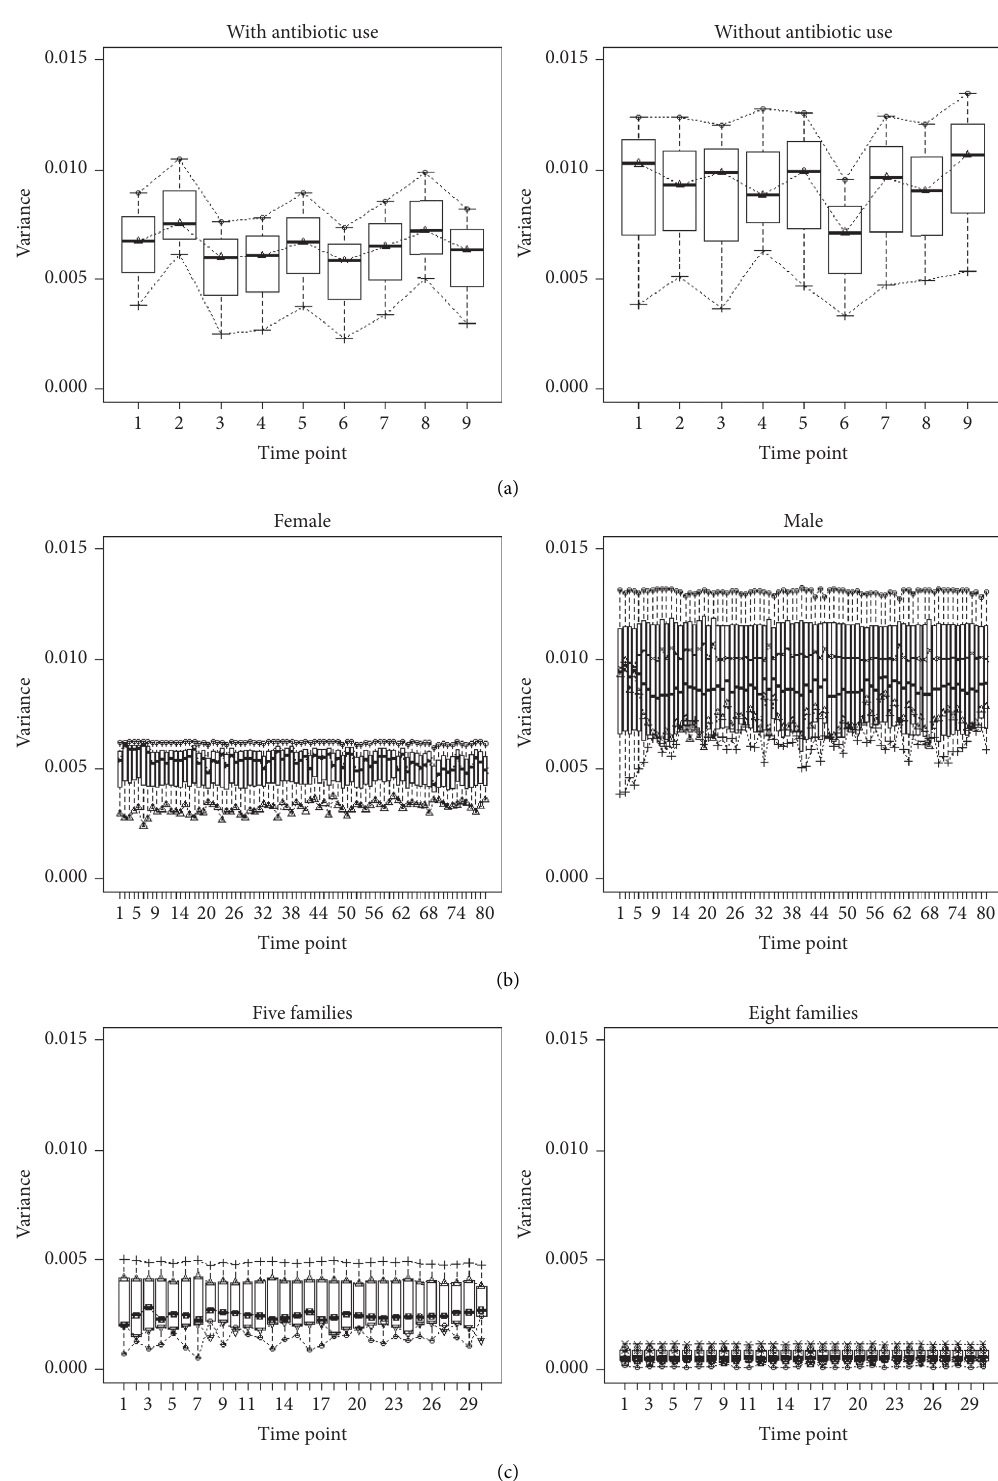
Figure 5: Variance time series for the subjects considered by Lloyd-Price et al. (a), Caporaso et al. (b), and simulated datasets (c), re- spectively. In this case, the markers are as follows: Other (+), Clostridiaceae ( △ ), and Bacteroidaceae ( ° ), for subjects reported by Lloyd-Price et al., and Other ( × ), Lachnospiraceae ( △ ), and Bacteroidaceae ( ° ), for individuals considered by Caporaso et